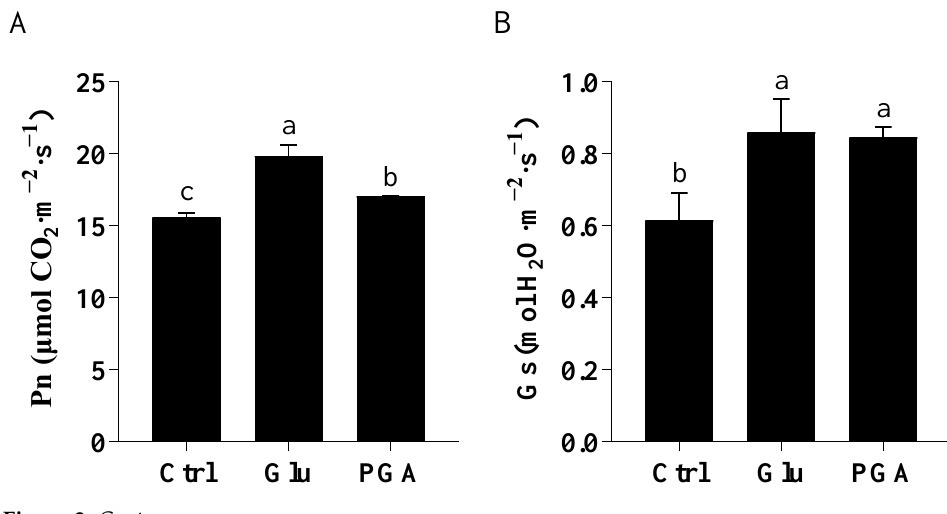
PGA0 Ctrl Glu Figure 3. Cont